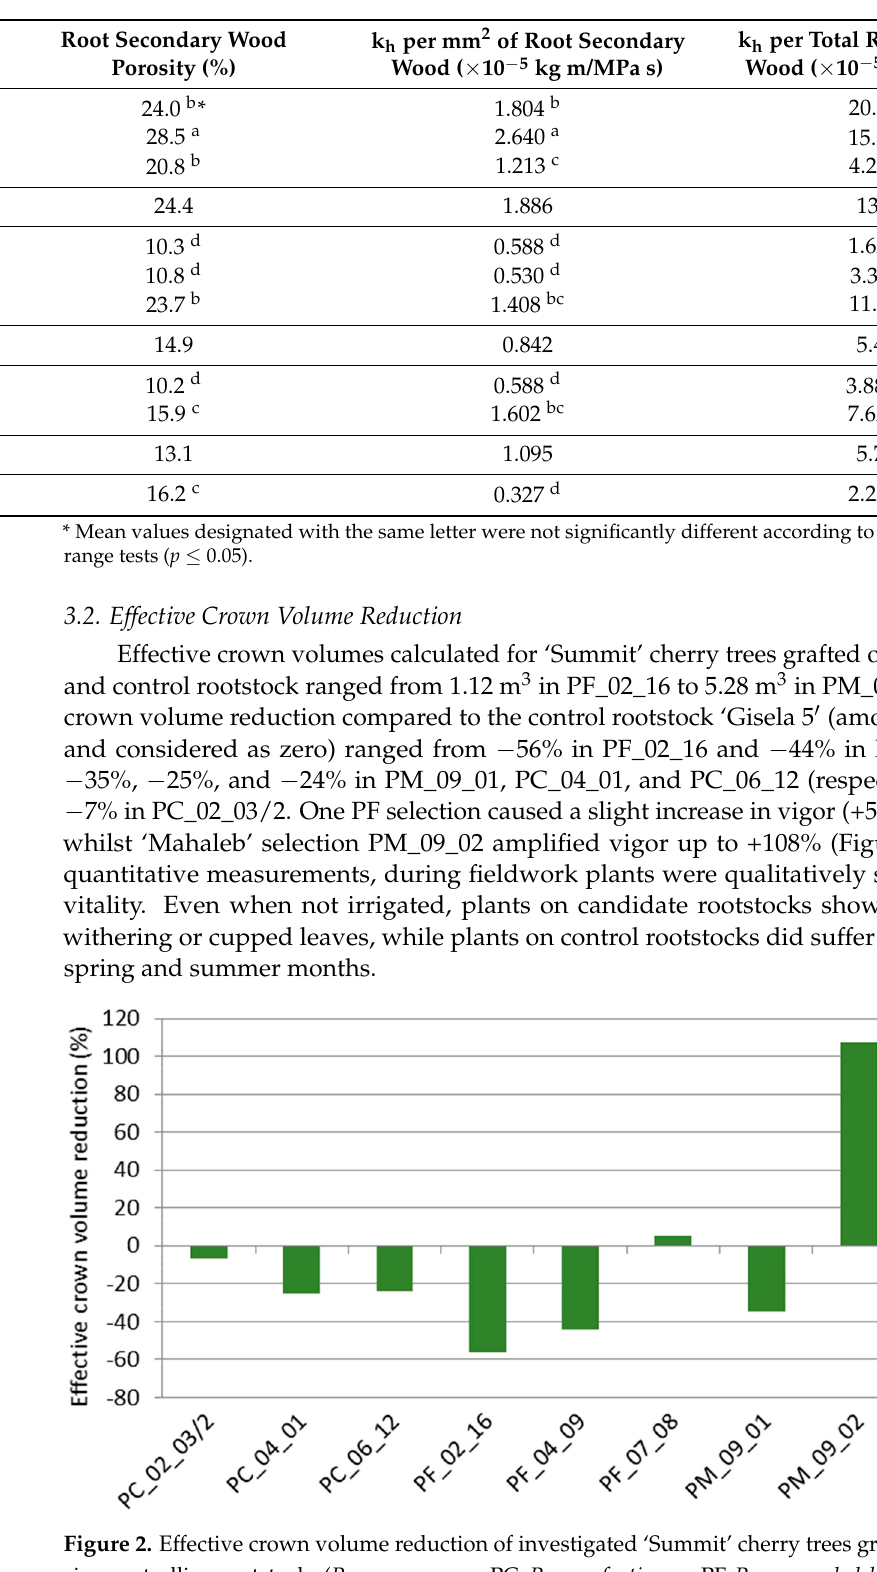
Table 4. Root porosity and theoretical hydraulic conductance (k h ) per mm 2 and total root area of the examined cherry rootstocks, belonging to Prunus cerasus (PC), Prunus fruticosa (PF), Prunus mahaleb (PM), species and control ‘Gisela 5 (cid:48) .